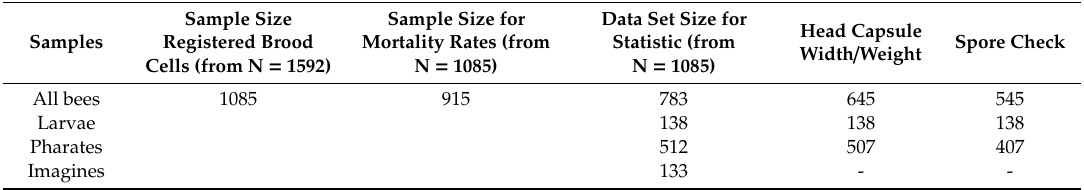
Table 1. Overview of study sampling.